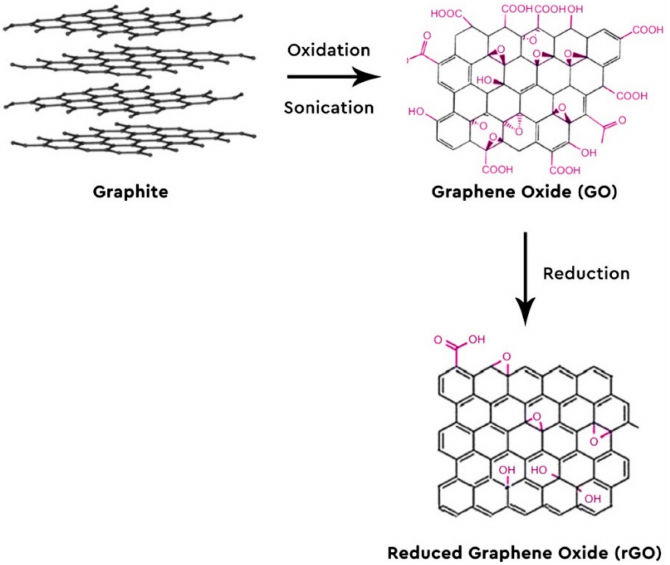
Figure 1. Synthesis of graphene oxide (GO) and reduced G (rGO) from graphite powder.